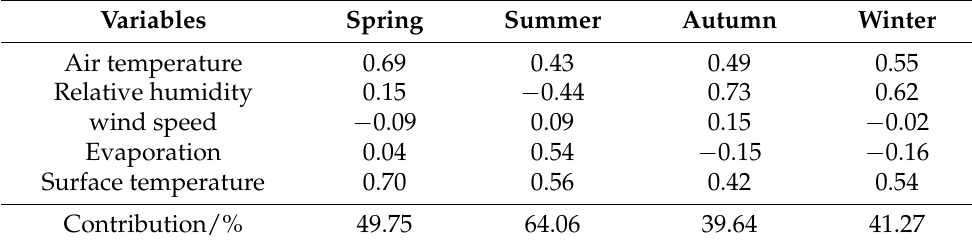
Table 1. The first principal component coefficients and contribution of meteorological factors on daily scales.